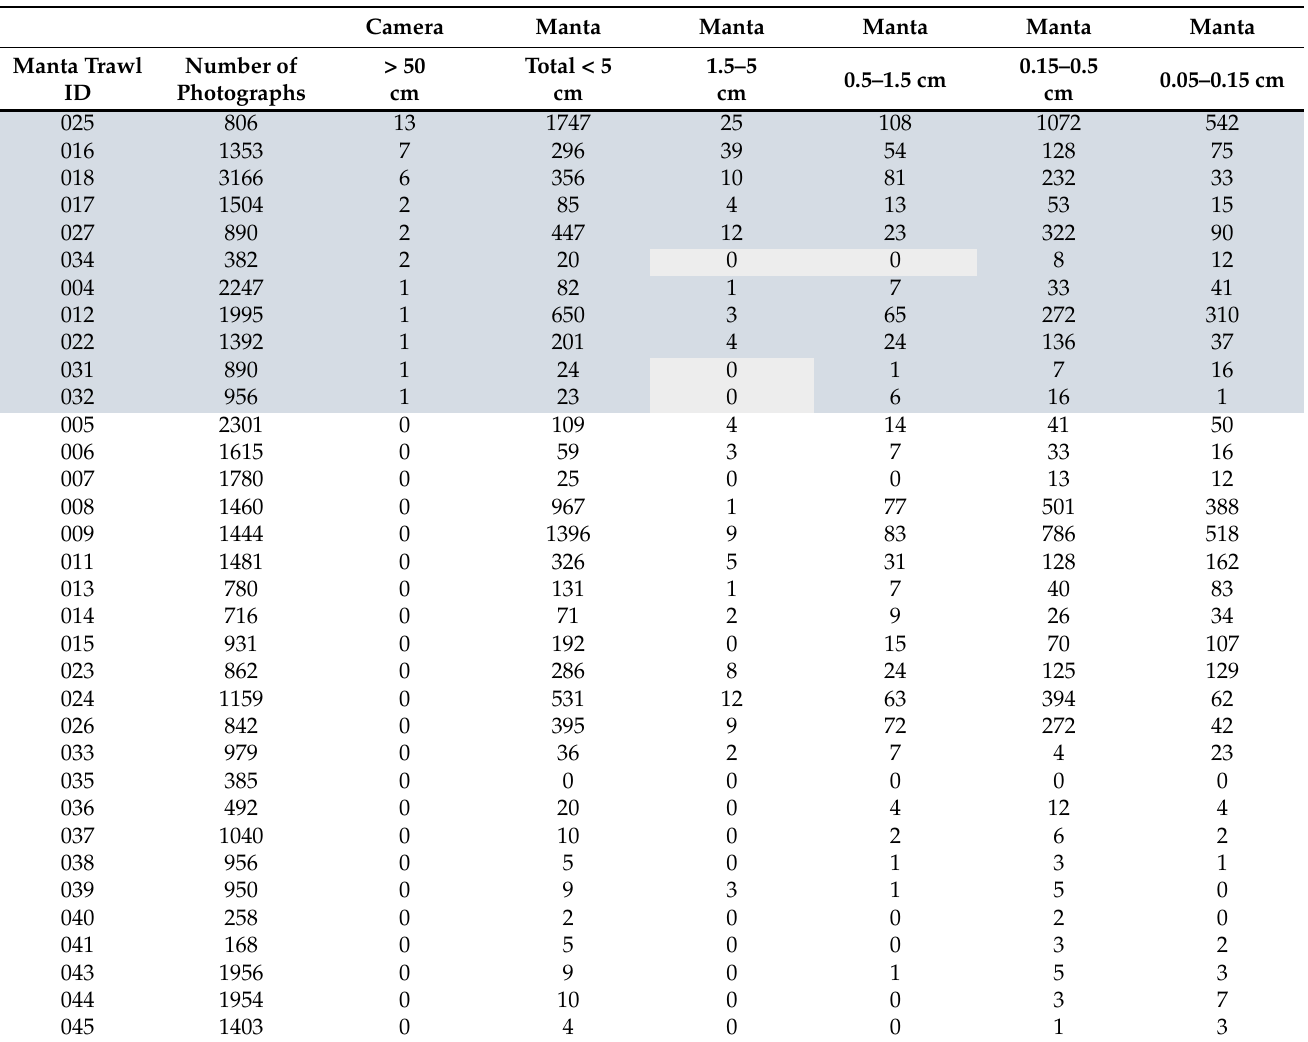
Table 2. Overview of Manta trawl sampling stations and the raw frequency of objects/particles observed in all size classes. The table sorting is in descending order by the number of macroplastic objects. Blue-gray shading indicates the 11 Manta trawl samples containing at least one macroplastic objects (>50 cm). Additional gray shading highlights Manta trawl samples for which no plastics were observed in the respective size class. Note that this table excludes Manta trawl sampling stations for which no photos were taken (camera off).